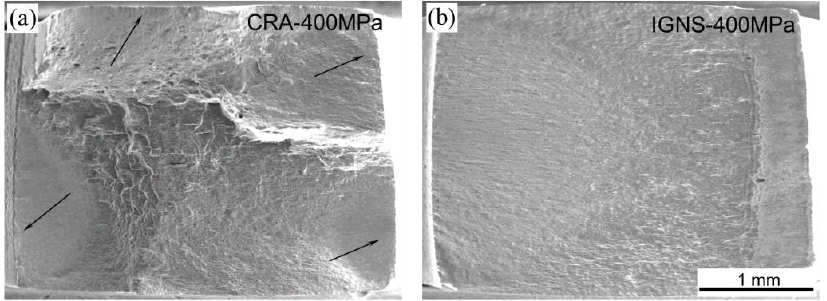
Figure 8. Fractography of ( a ) the CRA sample and ( b ) the IGNS sample under a stress amplitude of 400 MPa.